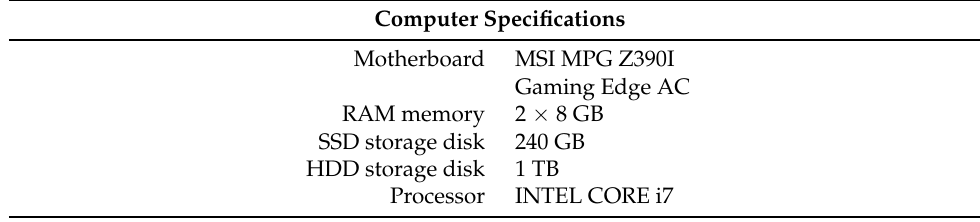
Table 3. Computer components and